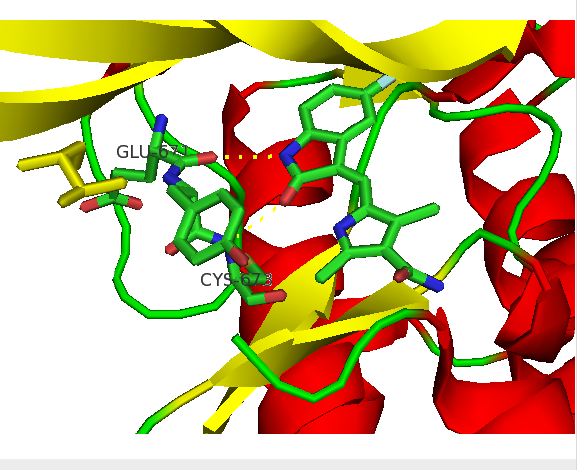
Figure 3: Binding pocket of sunitinib in the TRK